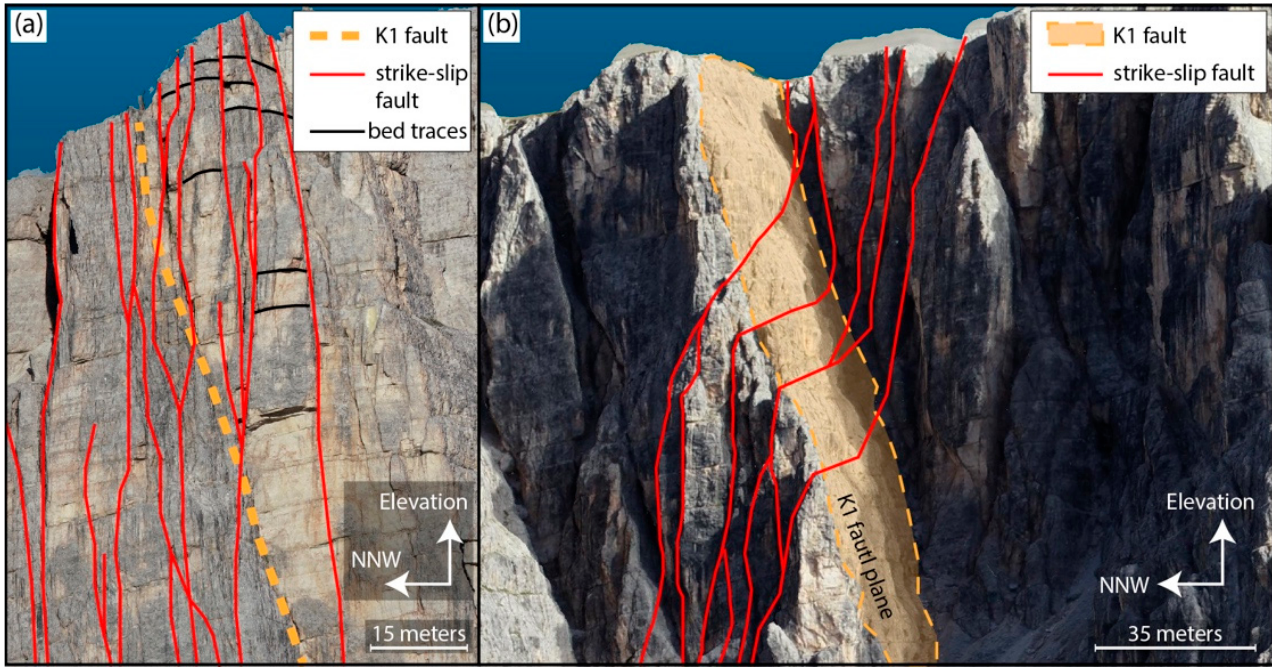
Figure 14. ( a ) Sub-vertical strike-slip faults that crosscut a K1 fault near Forcella Giau. The combination of strike-slip and compression generates an uplifted antiformal “dome” that forms the peak of Lastoni. ( b ) Detail of sub-vertical faults that crosscut a K1 fault plane along the western cliff of the outcrop.